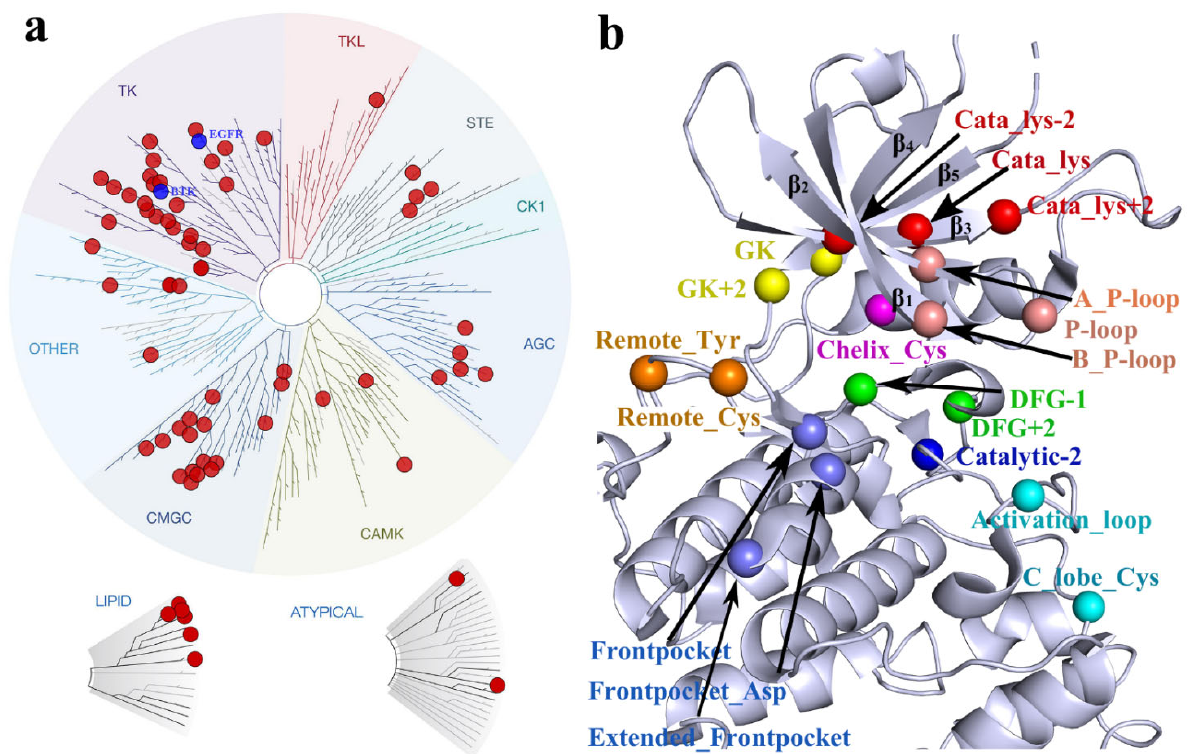
Figure 3. ( a ) Distribution of kinases with at least one CKI (the TREEspot tool www.discoverx.com, accessed on 20 May 2022). ( b ) Distribution of active amino acids as nucleophiles (PDB 5efq [35] as the kinase template).